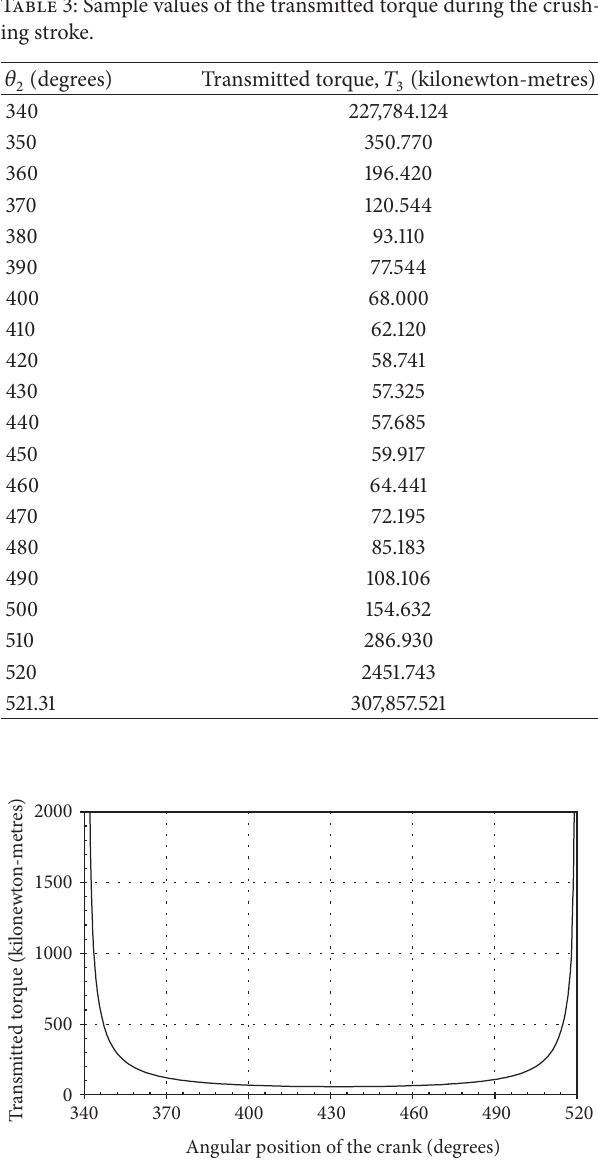
Figure 6: Variation of transmitted torque during a crushing